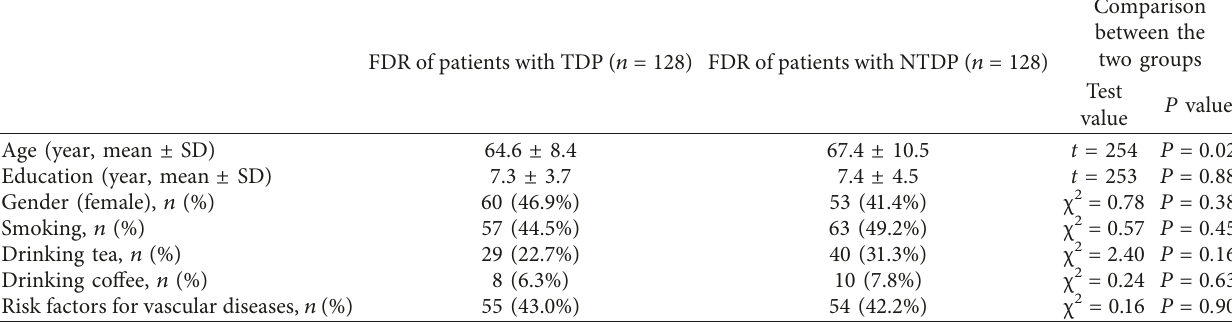
Table 3: Baseline data of the FDR of patients with TDP and